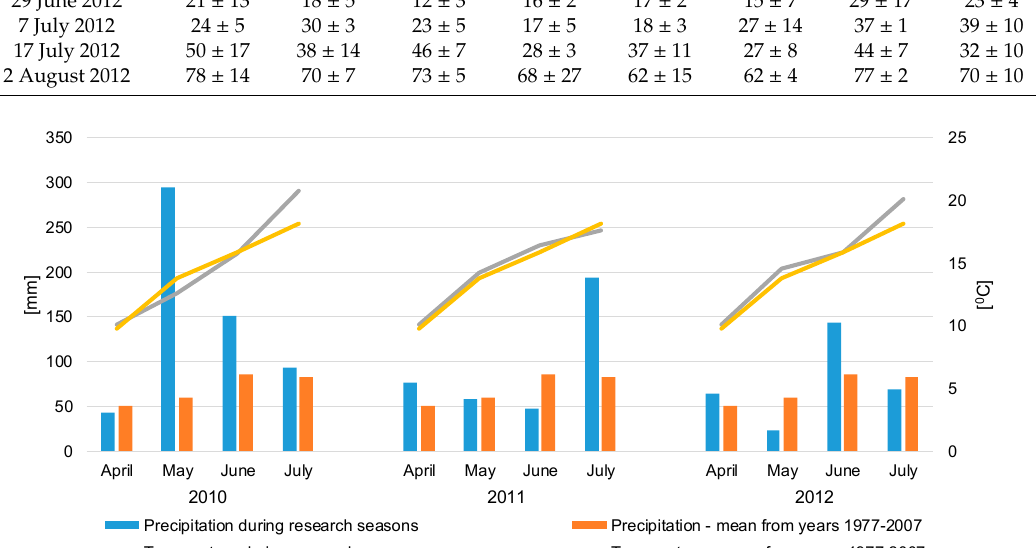
Figure 1. Monthly sum of precipitation and average daily temperature during the study period.